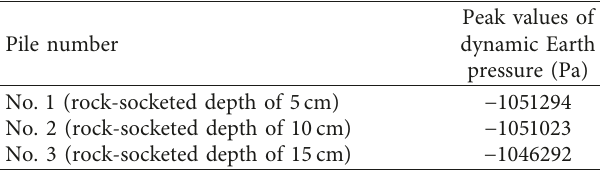
Table 5: Peak values of dynamic Earth pressure under different rock-socketed depths.